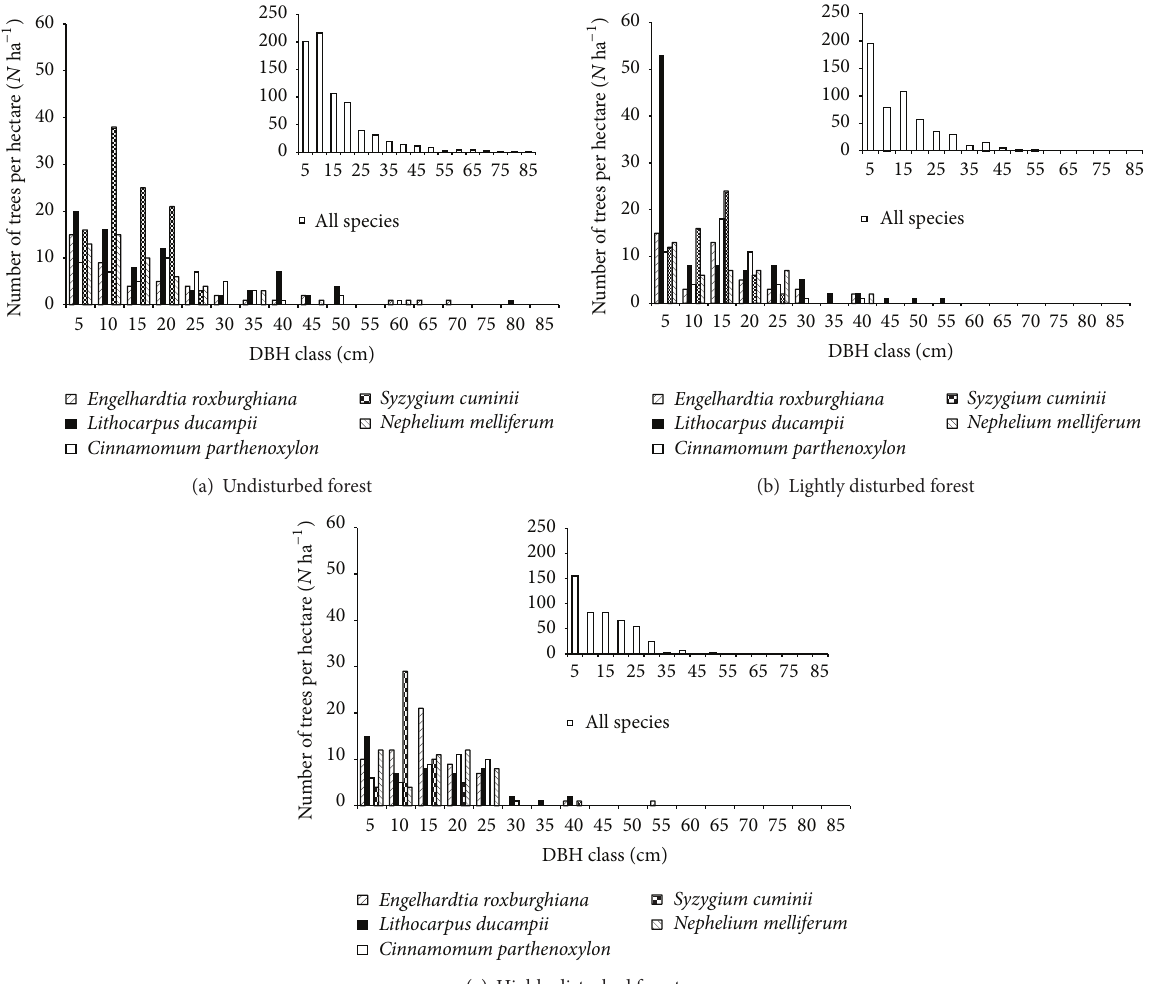
significant positive spatial association at scales of 5 and 31 m with a significant negative spatial association at 7, 9, and 30 m (Figure